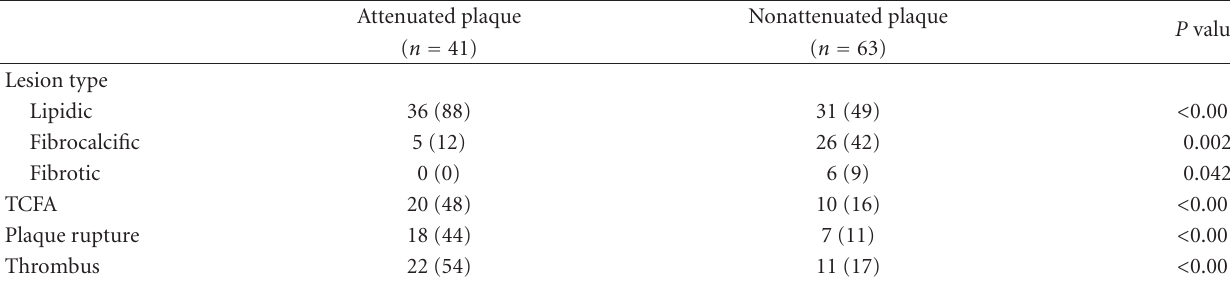
Table 3: Optical coherence tomography